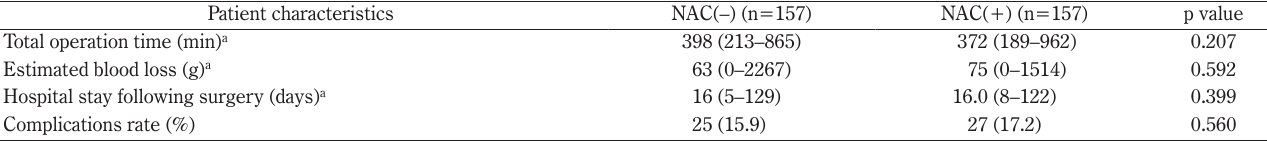
Table 4 Surgical outcomes and short-term postoperative courses in patients undergoing laparoscopic gastrectomy with or without NAC, after propensity score matching Patient